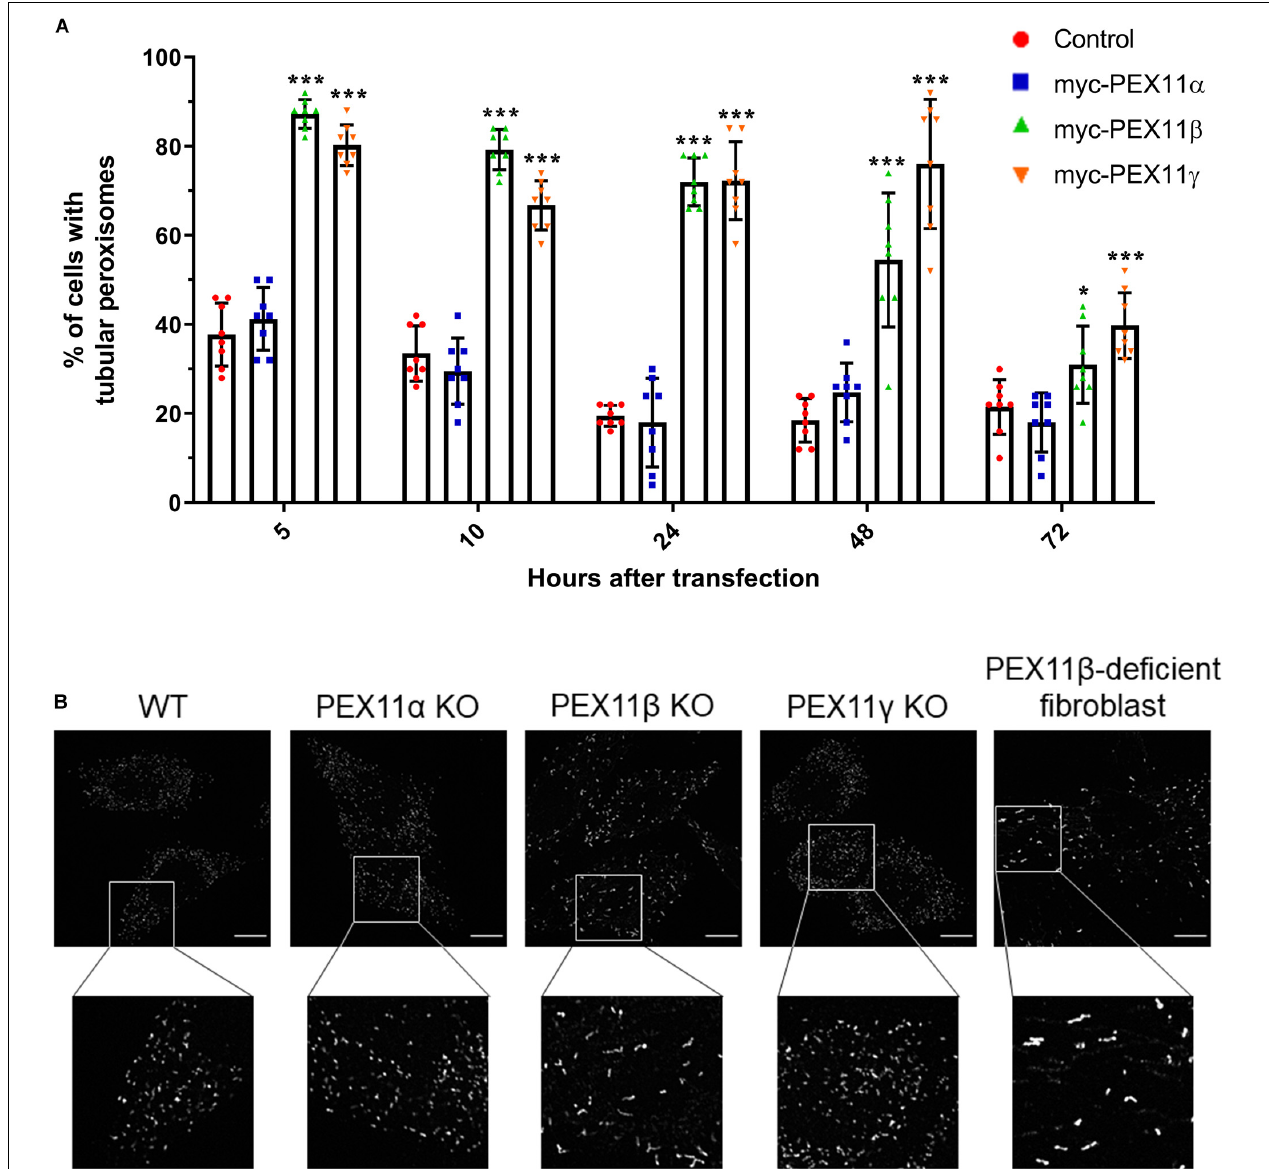
FIGURE 5 | The human PEX11 isoforms affect peroxisome morphology differently. (A) Quantitative analysis of peroxisome morphologies in cells expressing different human PEX11 isoforms. COS-7 cells were transfected with Myc-PEX11 α , Myc-PEX11 β , or Myc-PEX11 γ , processed for immunofluorescence using anti-Myc and anti-PEX14 antibodies at the indicated time points after transfection, and analyzed by microscopy. Note the prominent effect of Myc-PEX11 β and Myc-PEX11 γ on peroxisome elongation/division, in contrast to Myc-PEX11 α expression, which is similar to mock-transfected controls (Con). Data from 4 independent experiments; analyzed by one-way ANOVA with Dunnett’s post hoc test for each time point; * p < 0.05, *** p < 0.001. (B) HeLa PEX11 KO cells and controls, and PEX11 β -deficient fibroblasts were processed for immunofluorescence microscopy using antibodies against PEX14. Note the reduced number and elongation of peroxisomes in the PEX11 β -deficient cells. Bars, 10 µ